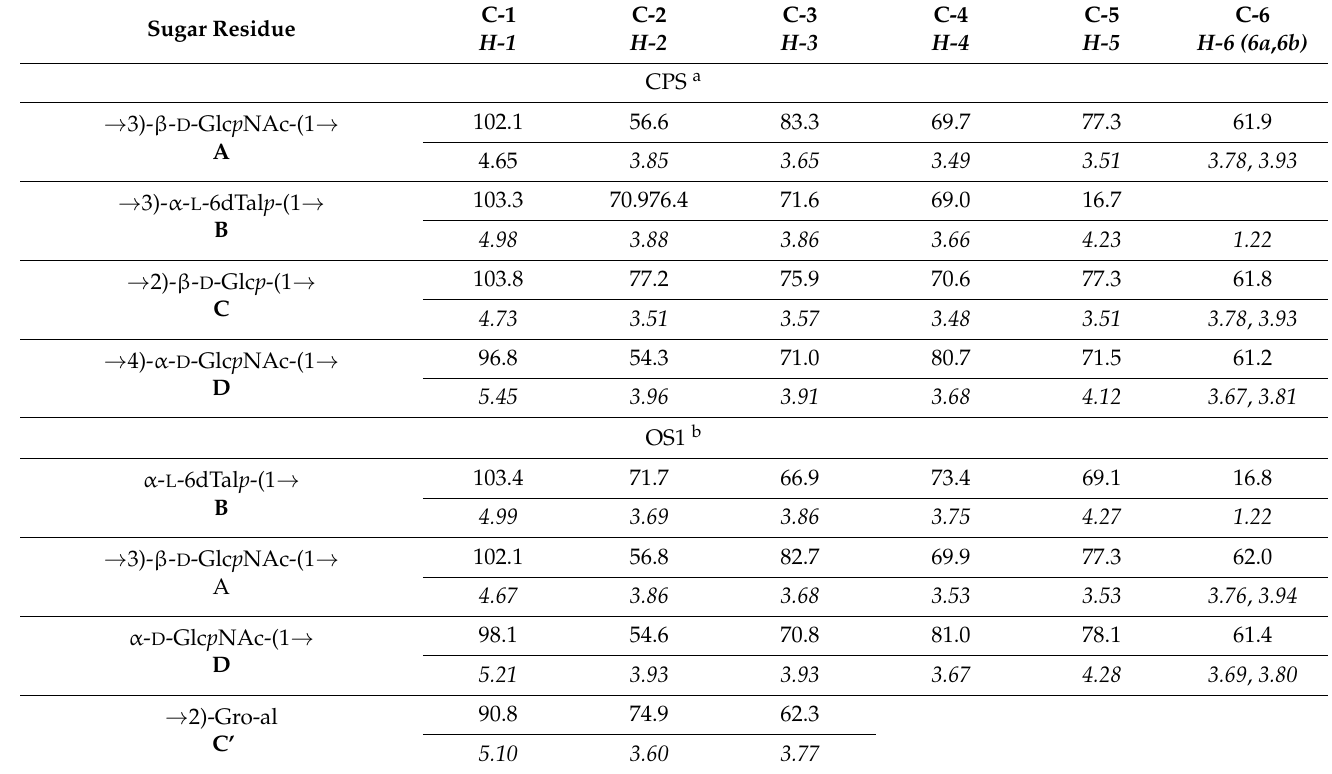
Table 1. 1 H and 13 C NMR chemical shifts ( δ , ppm) of the K106 capsular polysaccharide of A. baumannii 48-1789 and oligosaccharide OS1 derived by Smith degradation.